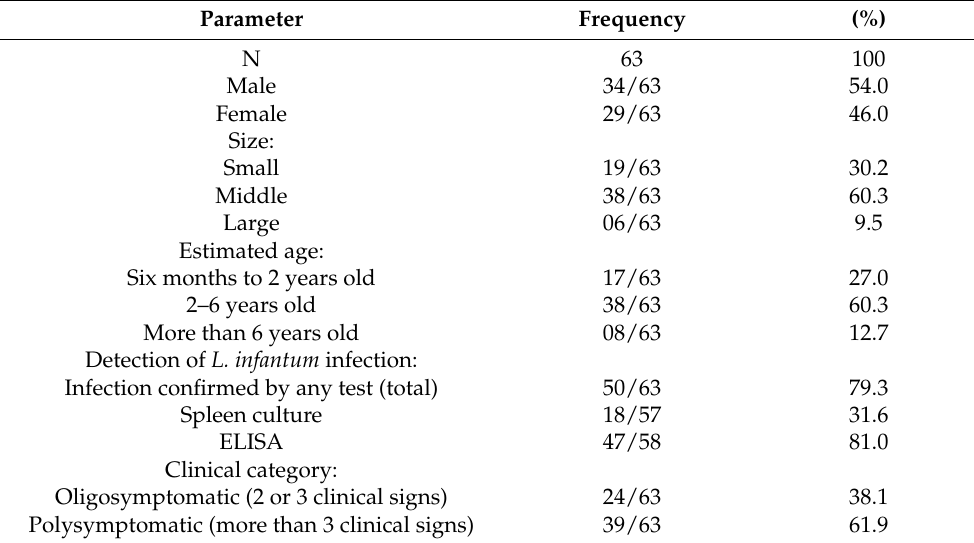
Table 1. General characteristics of semidomiciled dogs collected from the streets of Jequi é , BA, Brazil, in 2010.